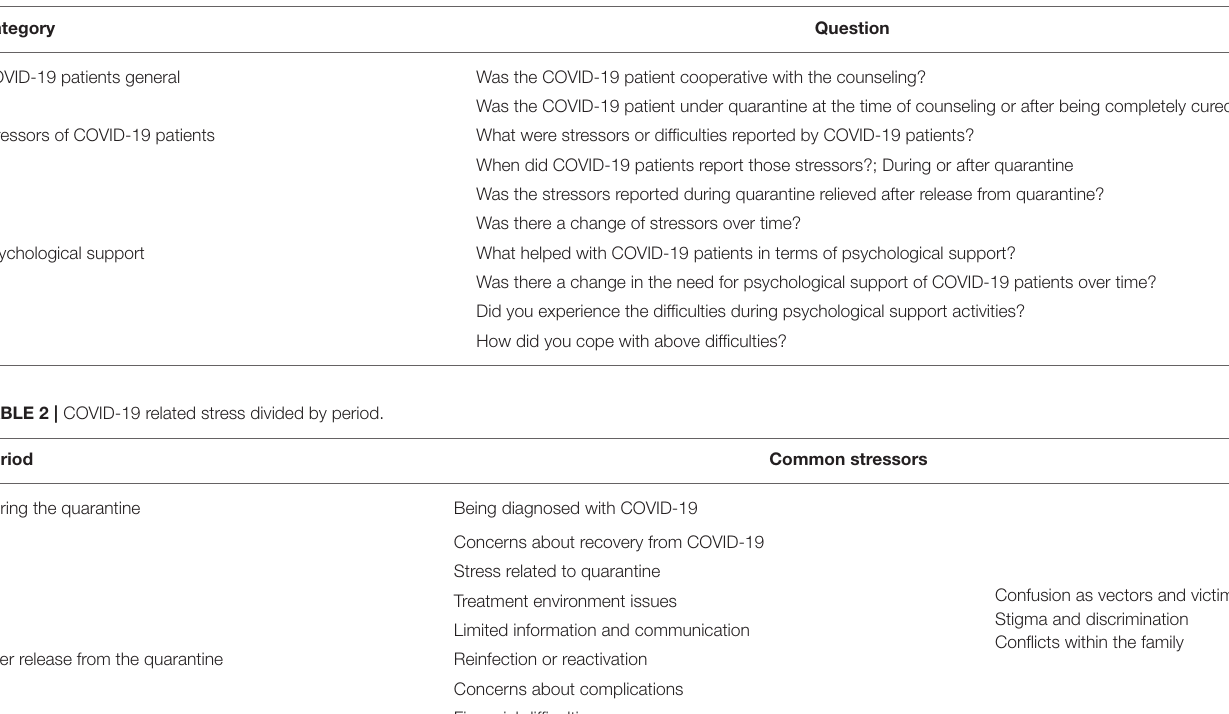
TABLE 1 | Focus Group Interview (FGI) questions.